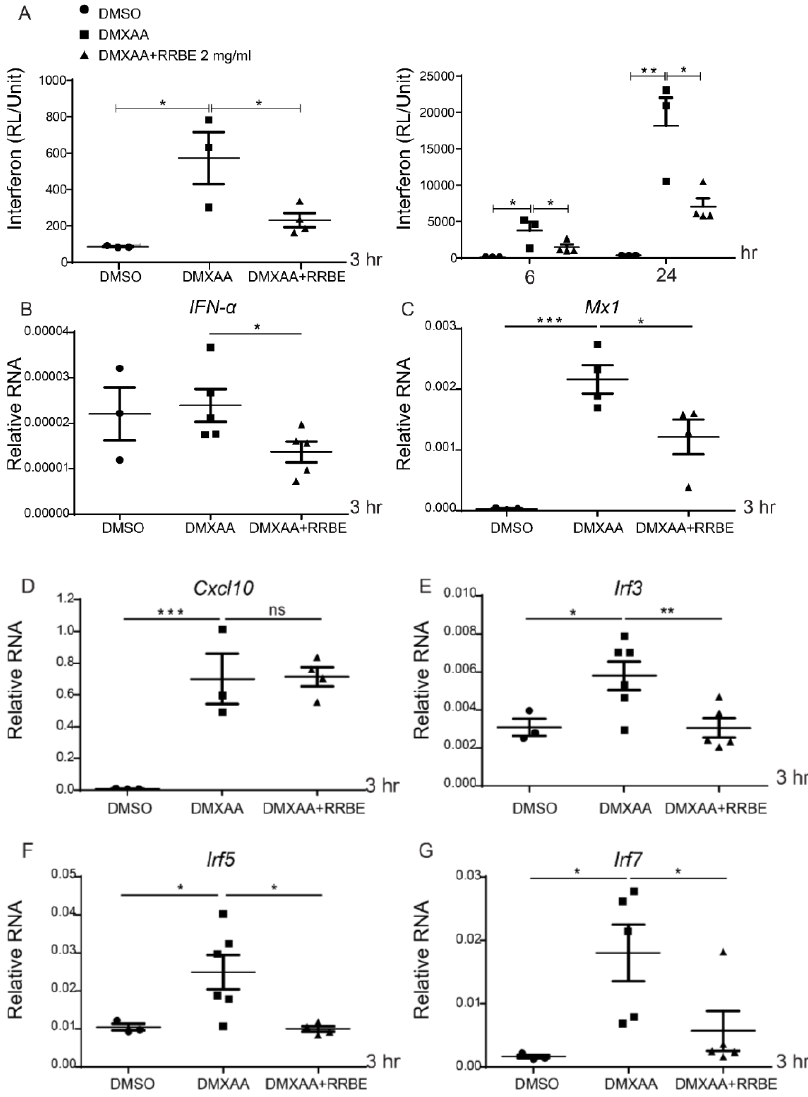
Figure 3. Effects of RRBE on the interferon-inducible gene expression. ( A ) The luminescence activity through STING signaling was determined after DMXAA activation with and without RRBE for 3, 6 and 24 h (N = 3 – 5). The relative mRNA expressions (normalized by actin) of ( B ) Ifn- α , ( C ) Mx1 , ( D ) Cxcl10 , ( E ) Irf3 , ( F ) Irf5 and ( G ) Irf7 after DMXAA stimulation with and without RRBE for 3 h (N = 3 – 4) are shown. Error bars indicate SEM, * p < 0.05, ** p < 0.01, and *** p < 0.001.